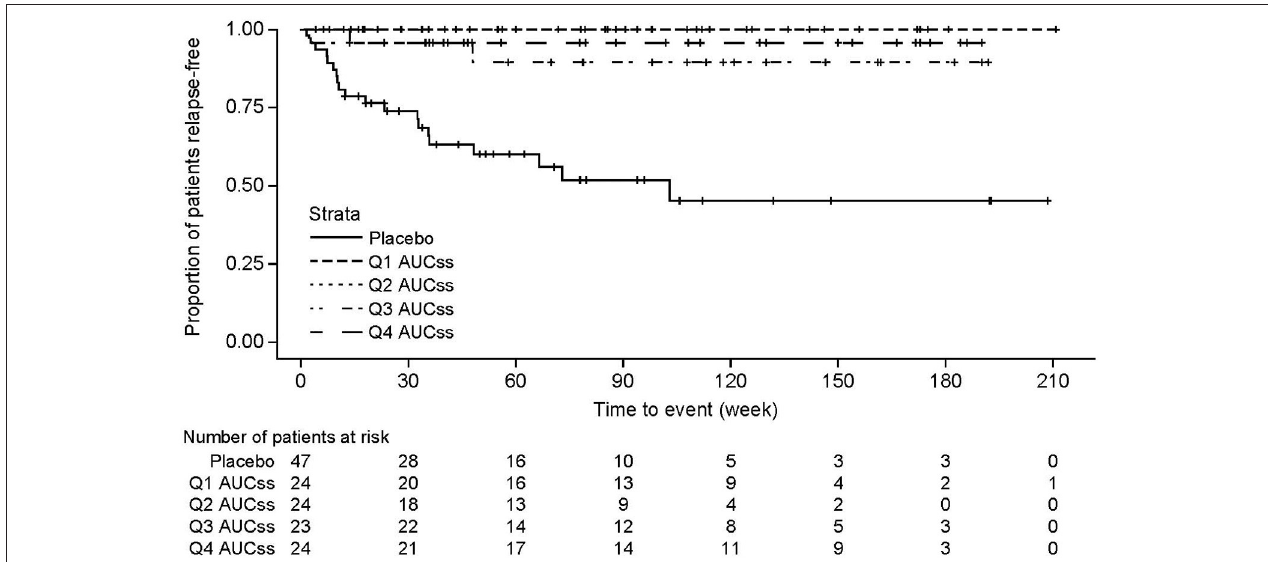
FIGURE 5 | Kaplan–Meier survival plots for time to first adjudicated on-trial relapse, according to eculizumab exposure. Relapse-free survival curves for each exposure quartile for time to first adjudicated on-trial relapse in eculizumab-treated patients. For comparison, the survival curve is also shown for patients receiving placebo. AUC ss is based on the maintenance dose of 1,200mg eculizumab. One eculizumab-treated patient for whom no post-hoc pharmacokinetic parameters were obtained was excluded from the analysis. AUC ss , area under the concentration–time curve within one dosing interval at steady state; Q1, 1st quartile; Q2, 2nd quartile; Q3, 3rd quartile; Q4, 4th quartile.